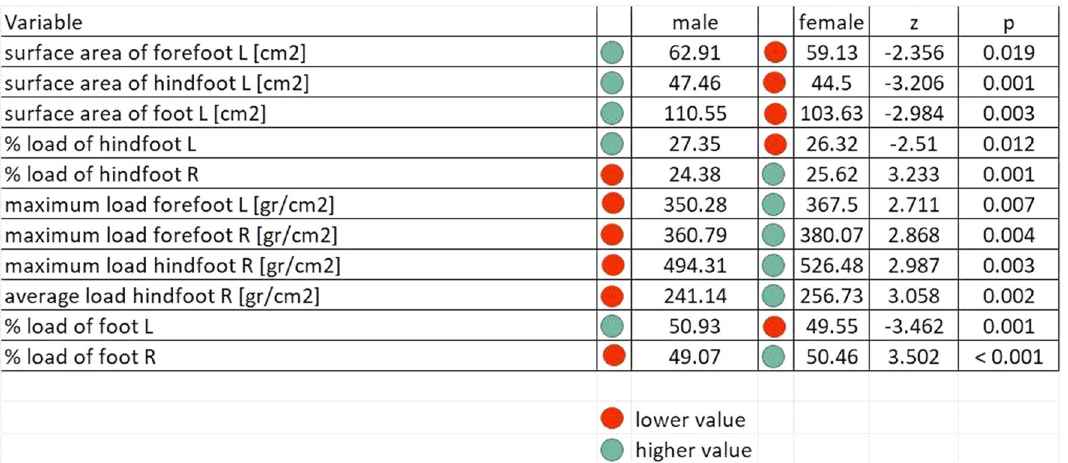
Table 2. Average values of the foot load variables, stratified by gender. Z—value of the Mann–Whitney- Wilcoxon test statistics for two independent results, p—level of significance.